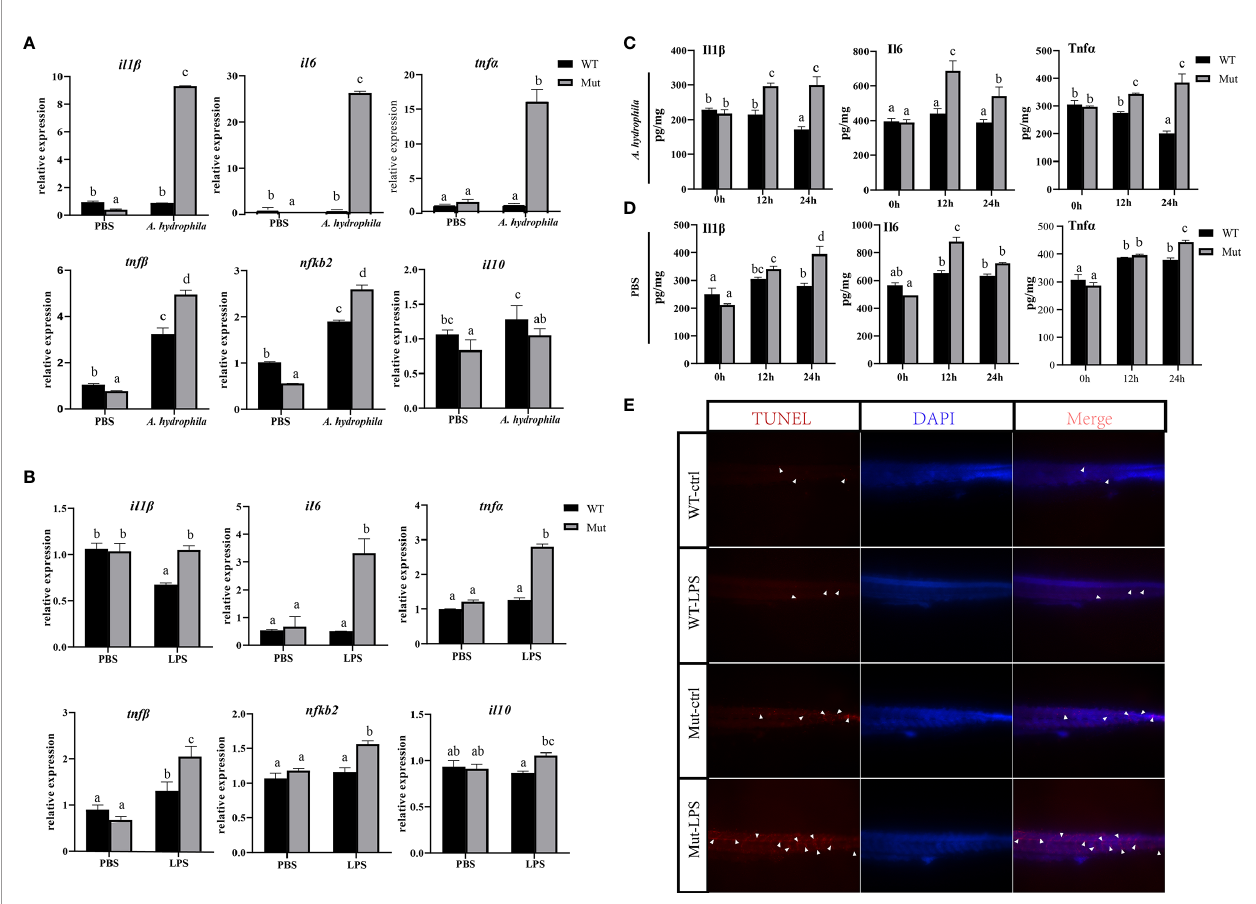
FIGURE 1 | Effects of congenital asplenia on in fl ammatory response in zebra fi sh larvae. (A) The expression of in fl ammatory response – related genes after pathogenic A. hydrophila infection in zebra fi sh larvae. (B) The expression of in fl ammatory response – related genes after LPS exposure. (C, D) The expression of Il1 b , Il6, and Tnf a proteins after A. hydrophila challenge and LPS by ELISA. (E) A high aggregation of apoptotic cells was observed in the trunk of congenitally asplenic zebra fi sh by TUNEL assay. The white arrowhead indicates TUNEL-positive cells. Different letters (a, b, c, etc.) indicate signi fi cant differences ( p <